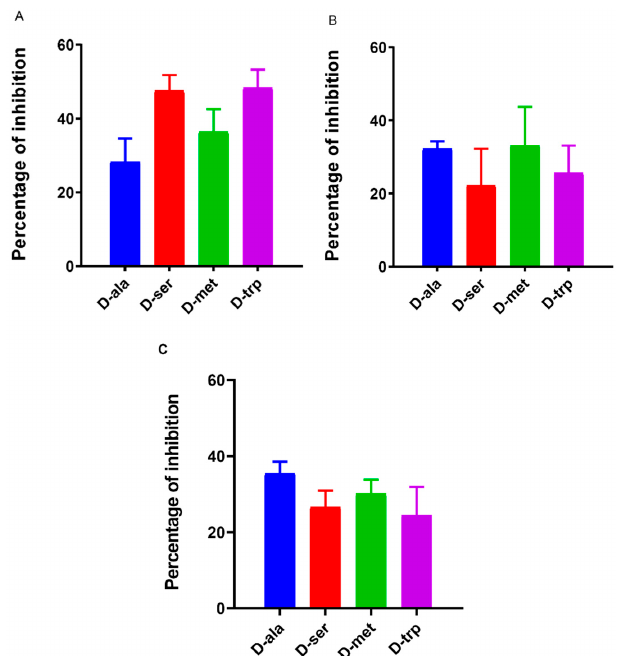
Figure 3. Quantitative analysis of biofilm inhibition of ( A ) C. jejuni 11168-O, ( B ) C. jejuni 81-176, and ( C ) C. coli NCTC 11366 in the presence of 10 mM of DAs. The data is presented as Mean ± Standard errors of Percentage of inhibition (Normalized to untreated control).